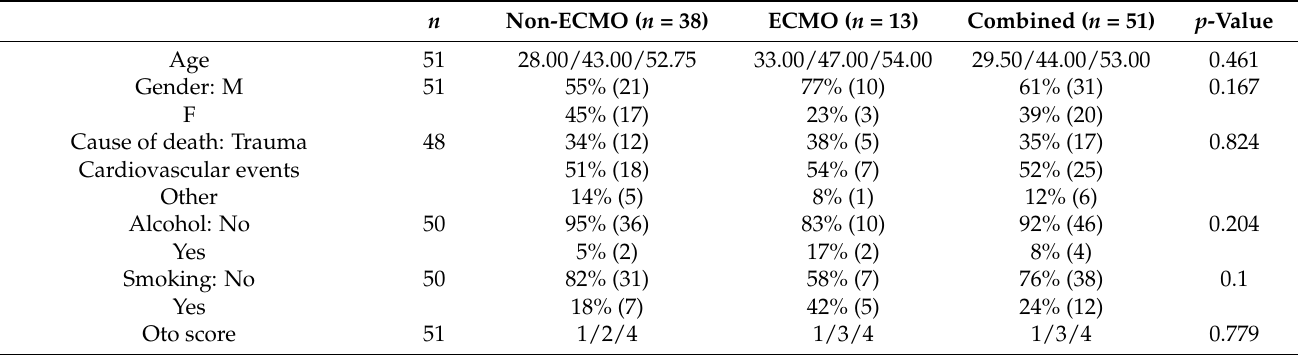
Table 2. Donor characteristics: descriptive statistics. Continuous data are reported as medians (I, III quartiles); categorical data are reported as percentages and absolute frequencies. Wilcoxon-type tests were performed for continuous variables, and Pearson chi-square tests were performed for categorical